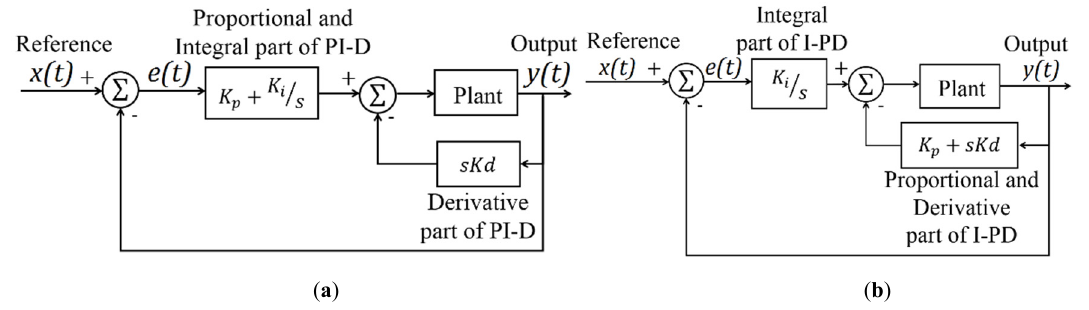
Figure 7. Block diagrams of Proportional ‐ Integral ‐ Derivative (PID) control variations: ( a